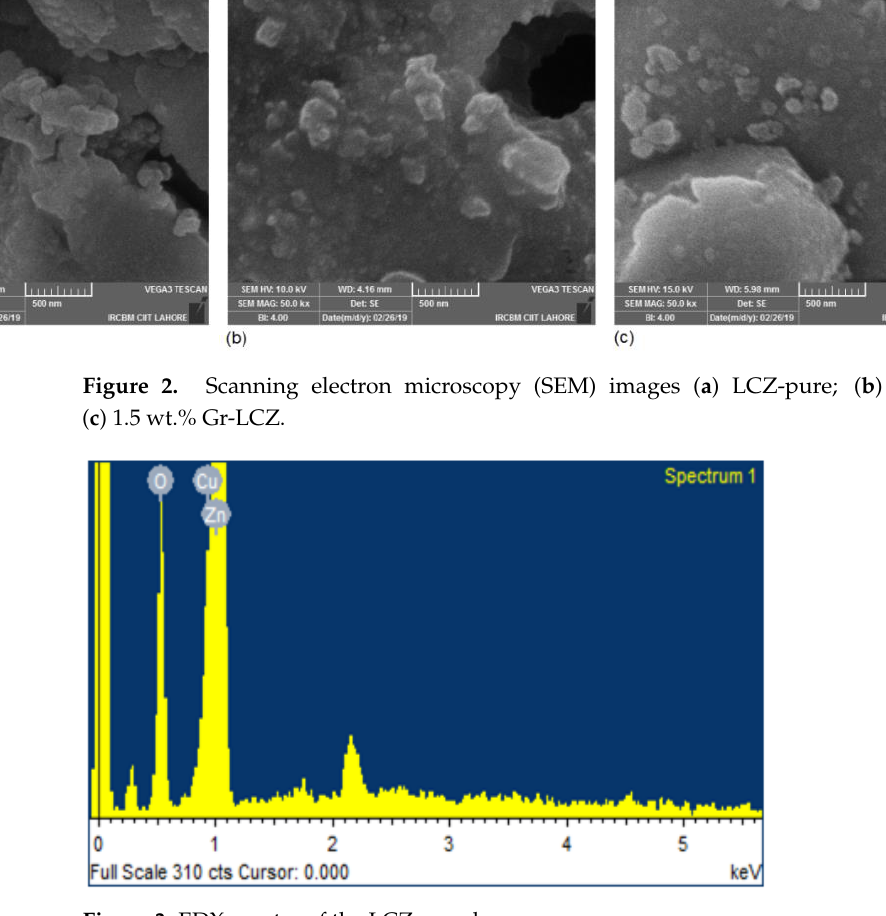
Figure 3. EDX spectra of the LCZ